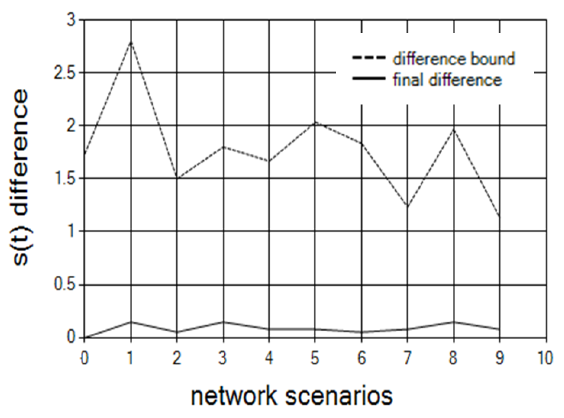
Figure 6. Difference bound and the final difference results.